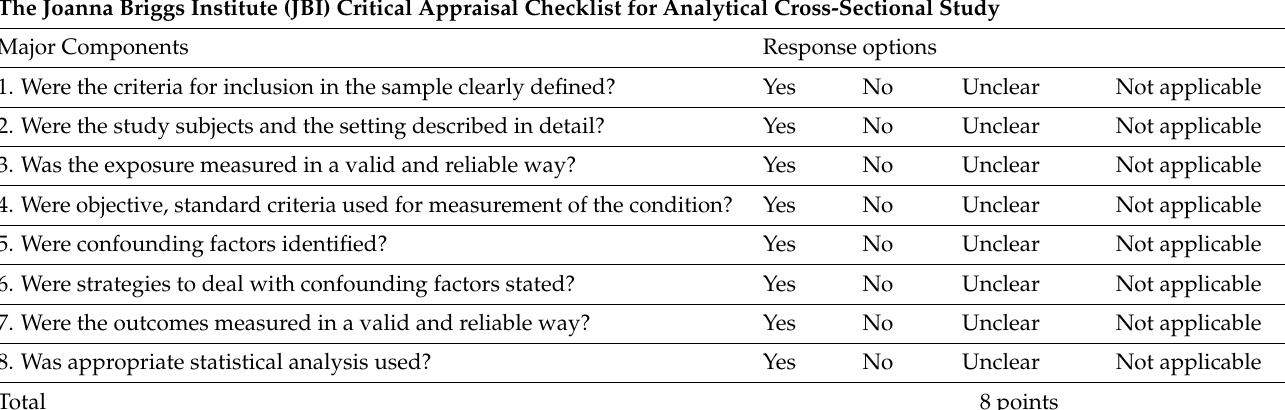
Table 1. JBI Critical Appraisal Checklist for Analytical Cross-Sectional Studies.